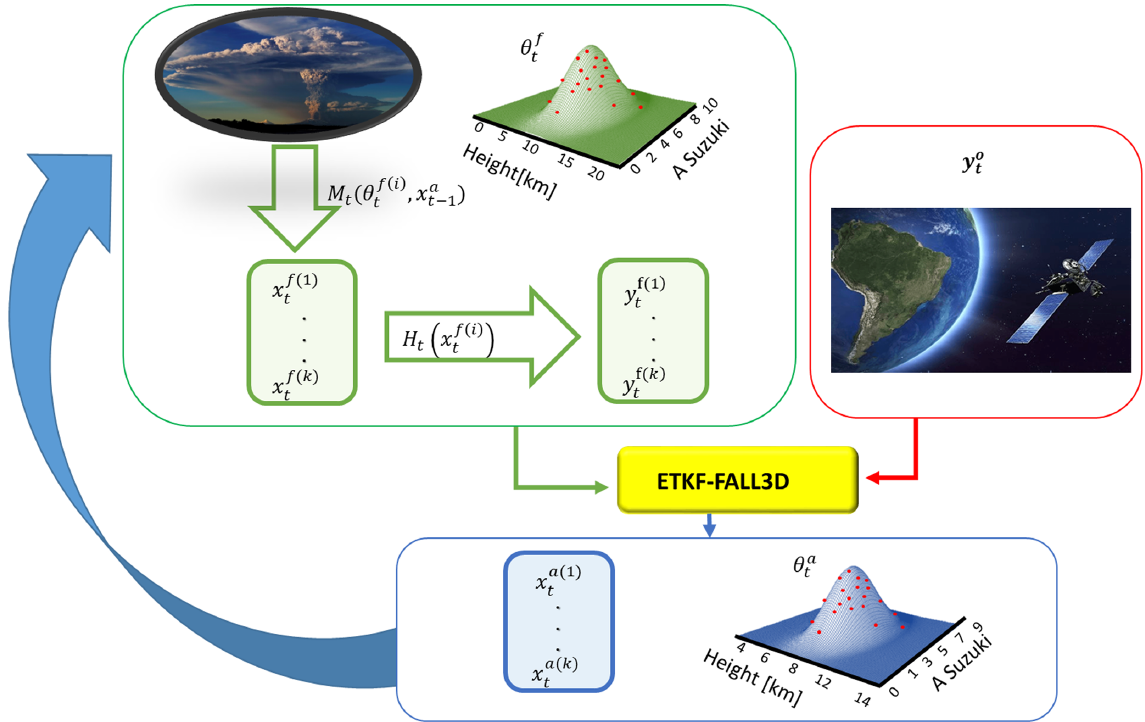
Figure 2. ETKF–FALL3D data assimilation system scheme for volcanic